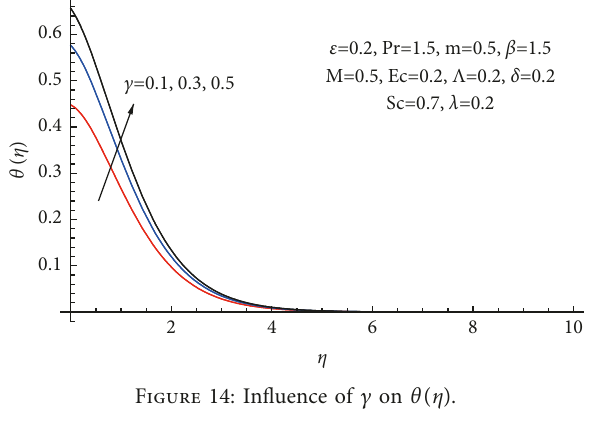
Figure 13: Influence of δ on θ ( η ) .